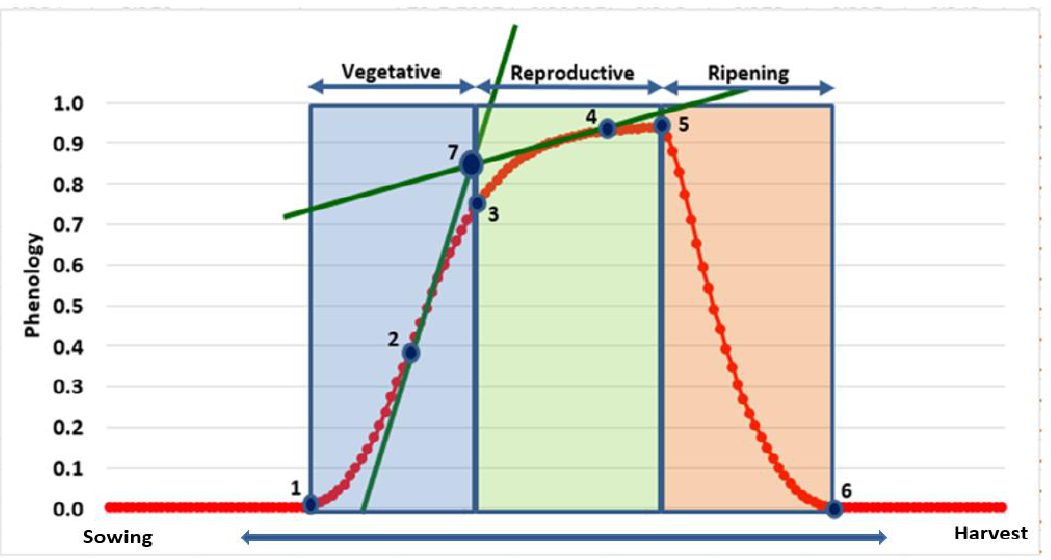
Figure 2. Phenological development phases (See text for explanation of the numbers).